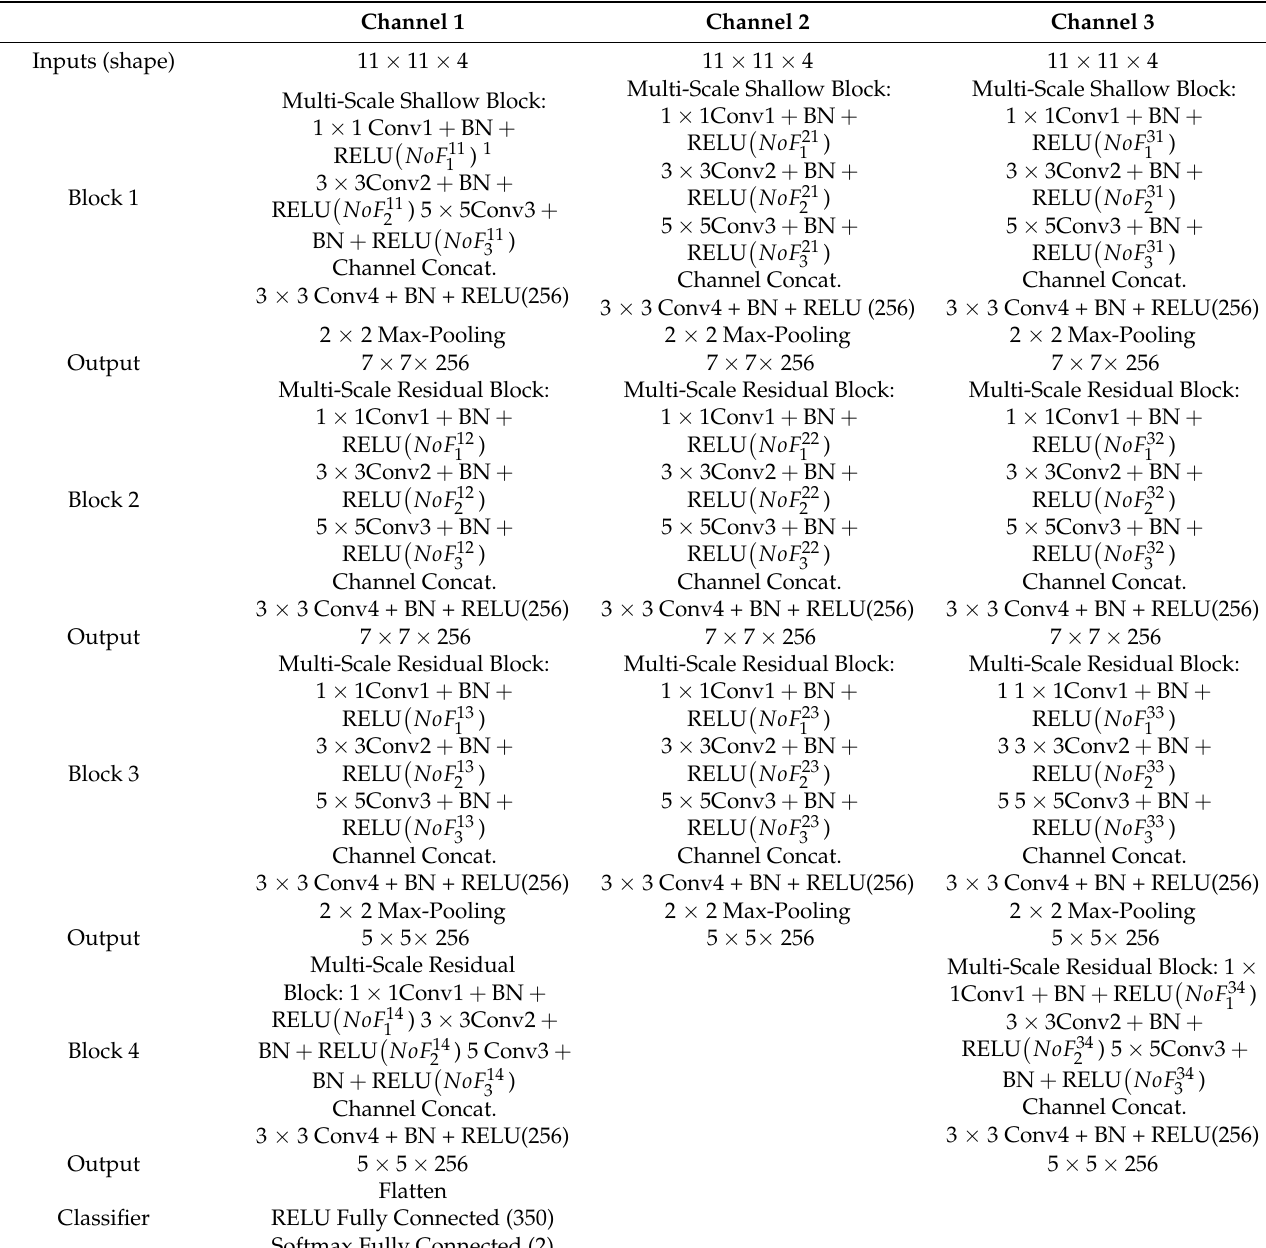
Table 2. TCD-Net configurations of each channel and